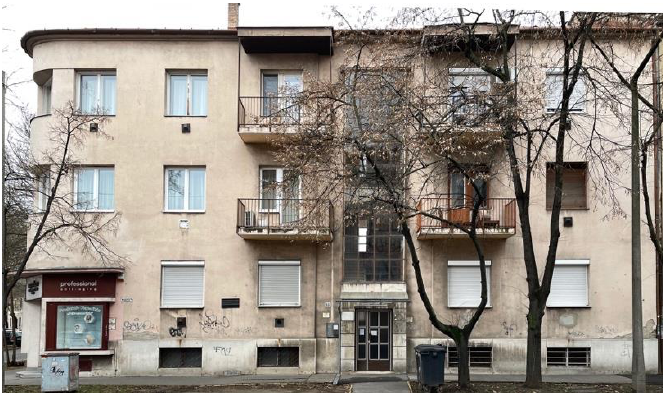
Figure 4. 15a Kazinczy street, Miskolc. Architect: Victor Bohm, 1936. Source: Lovra 2021.